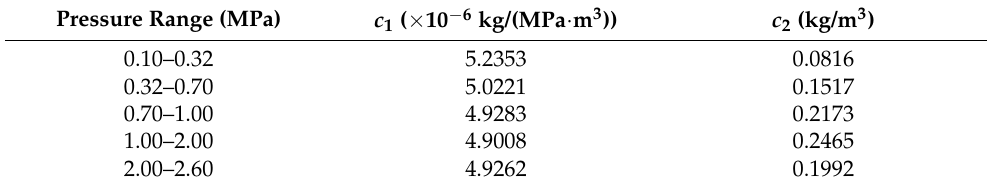
Table 1. Values of the fitting coefficients for saturated steam density